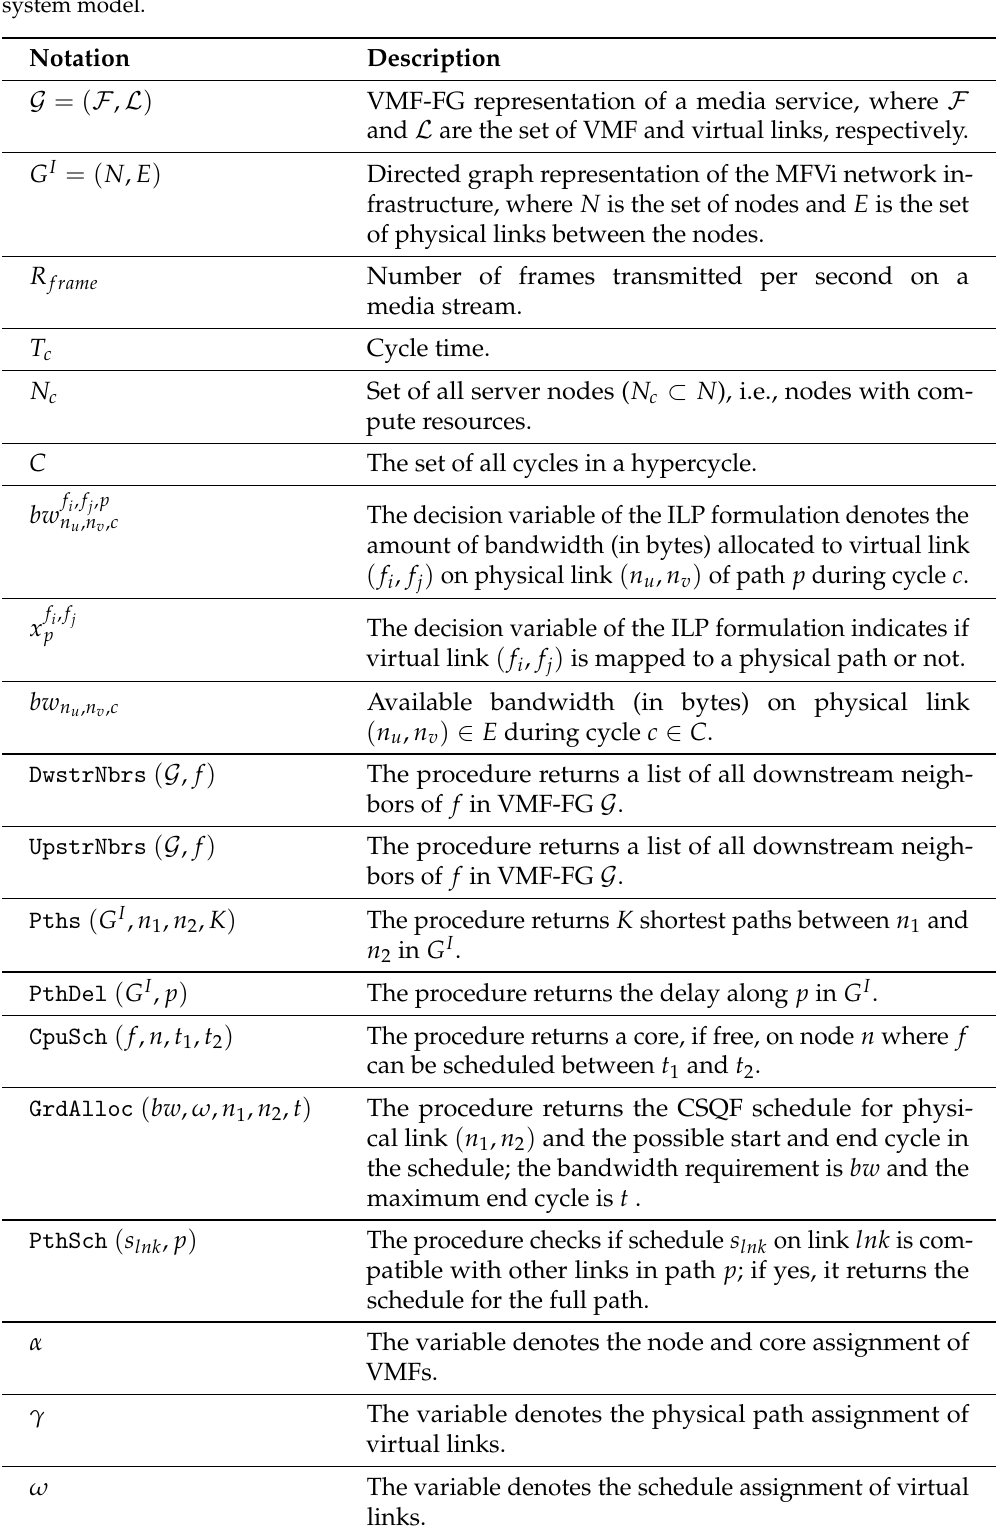
Table 1. Description of the notations used for different parameters and variables involved in the system